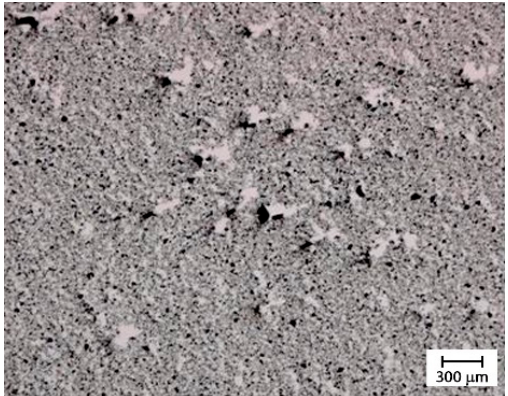
Figure 8. Optical micrograph of the dispersion obtained applying ultrasounds at 100% intensity for 30 min.